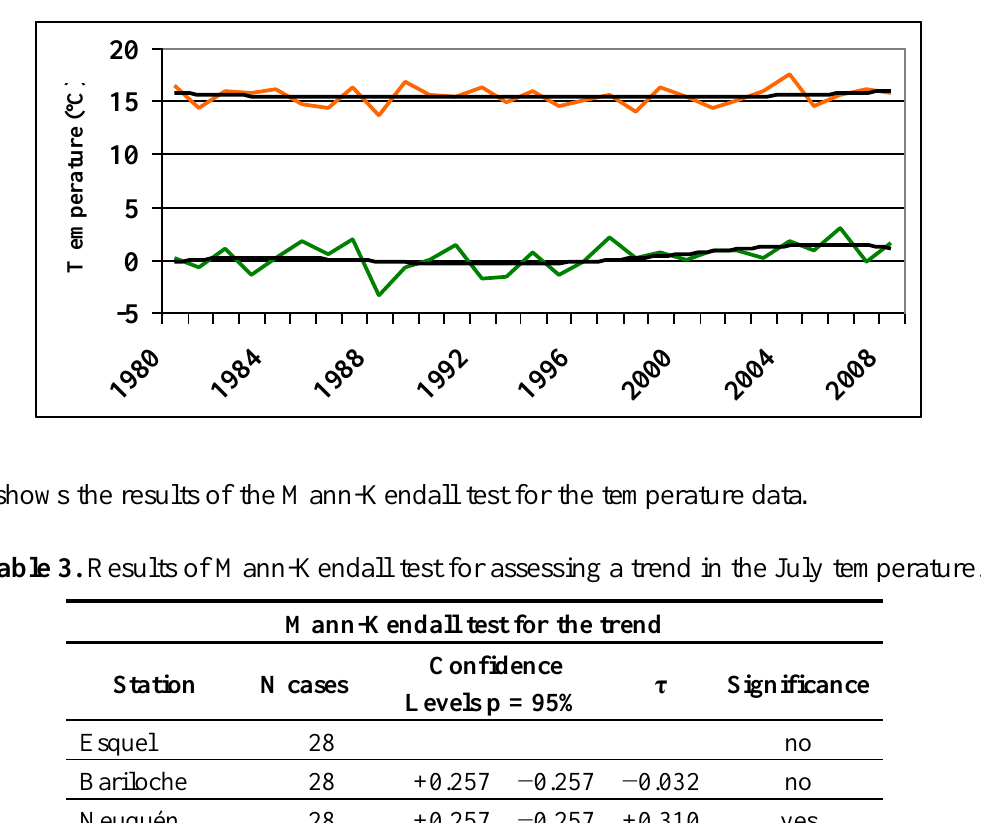
Figure 6. July mean maximum (orange) and mean minimum (green) temperatures, together with the corresponding linear trends (black), recorded at Neuquén.